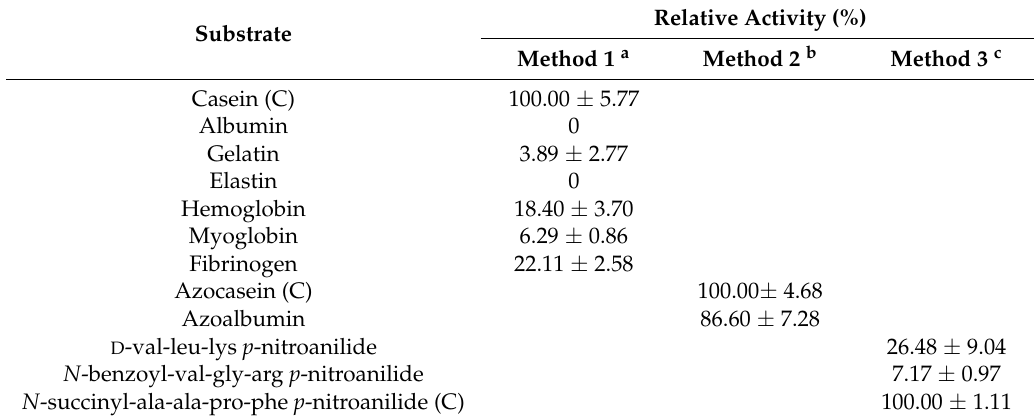
Table 2. Substrate specificity of TKU004P.